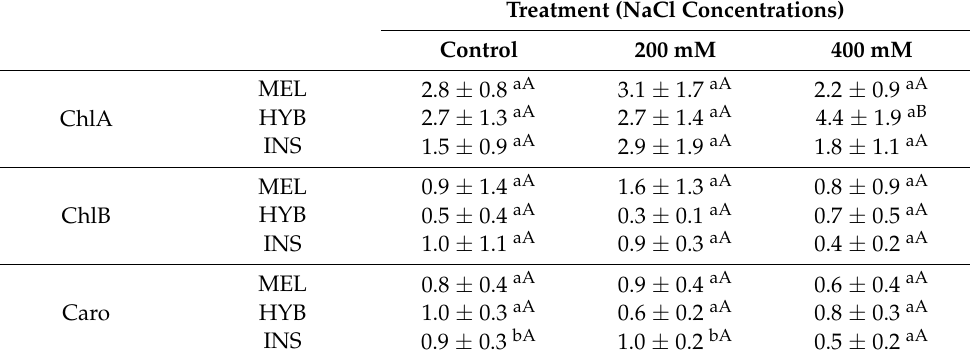
Table 3. Chlorophyll a (ChlA) (mg g − 1 dry weight), chlorophyll b (ChlB) (mg g − 1 dry weight) and carotenoids (Caro) (mg g − 1 dry weight) values (mean ± SD; n = 5) in Solanum melongena